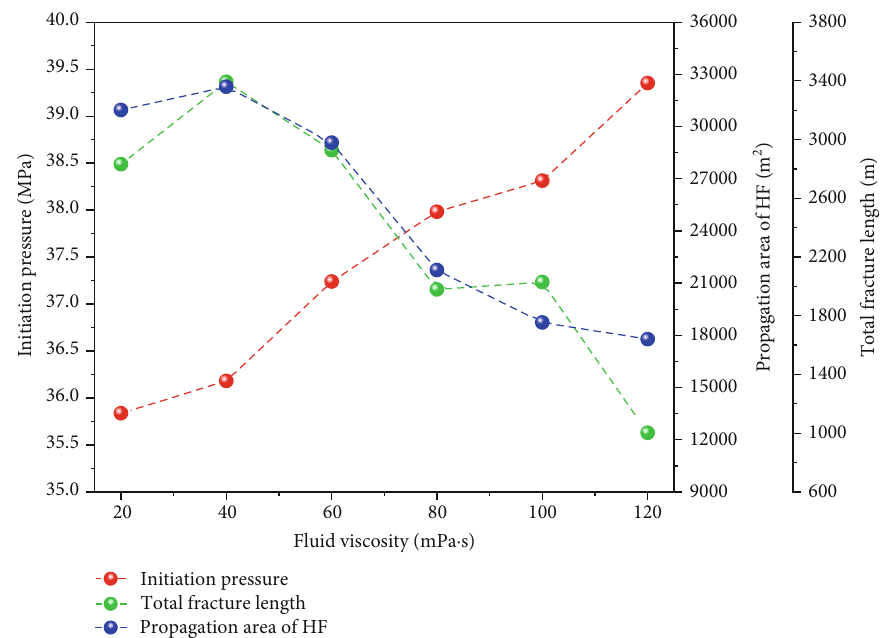
Figure 23: Total equivalent hydraulic fracture length and propagation area of the complex fracture